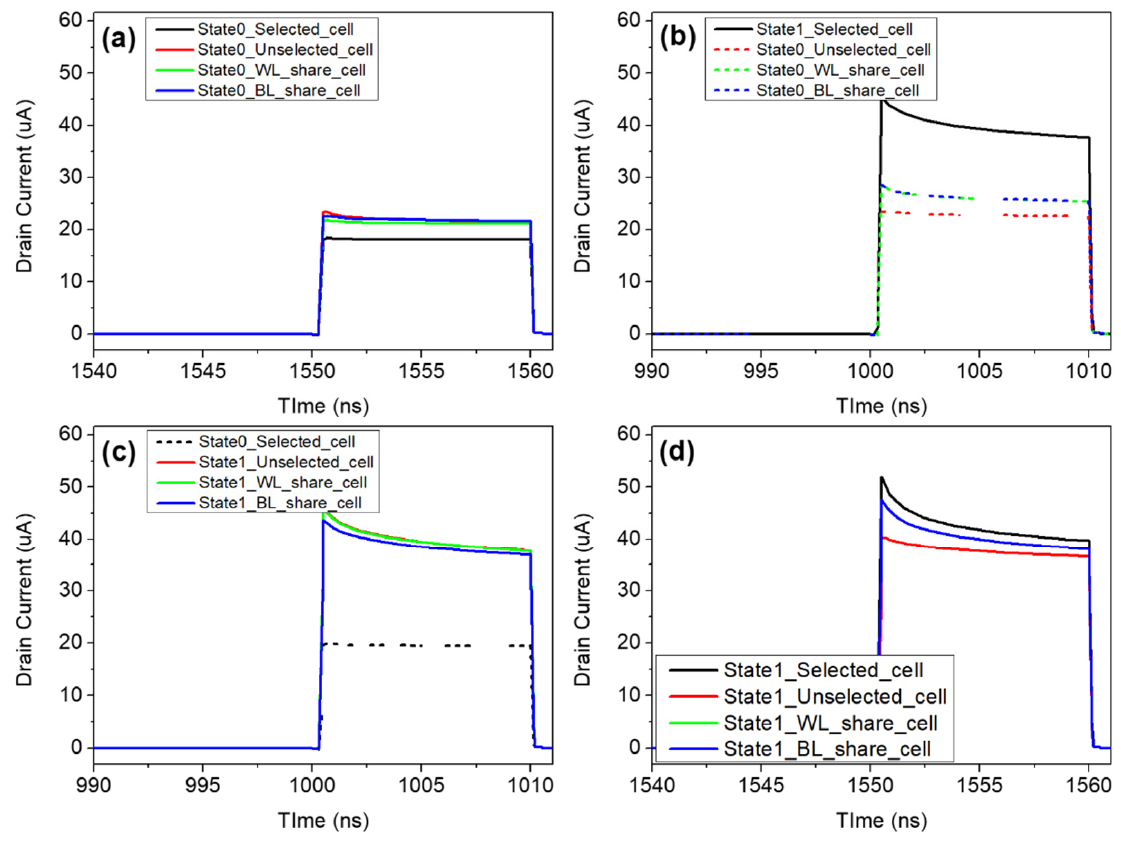
Figure 12. Read current of each cell location in ( a ) “0”-“0” case, ( b ) “0”-“1” case, ( c ) “1”-“0” case, and ( d ) “1”-“1” case. Table 5. Read current value at each location at 10 ns after application of the read voltage in the four cases.